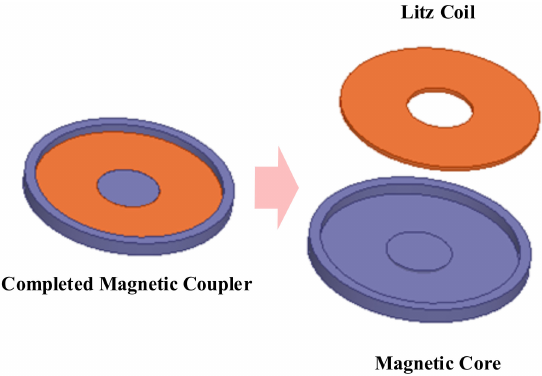
Figure 14. Magnetic circuit optimization of the magnetic coupler.